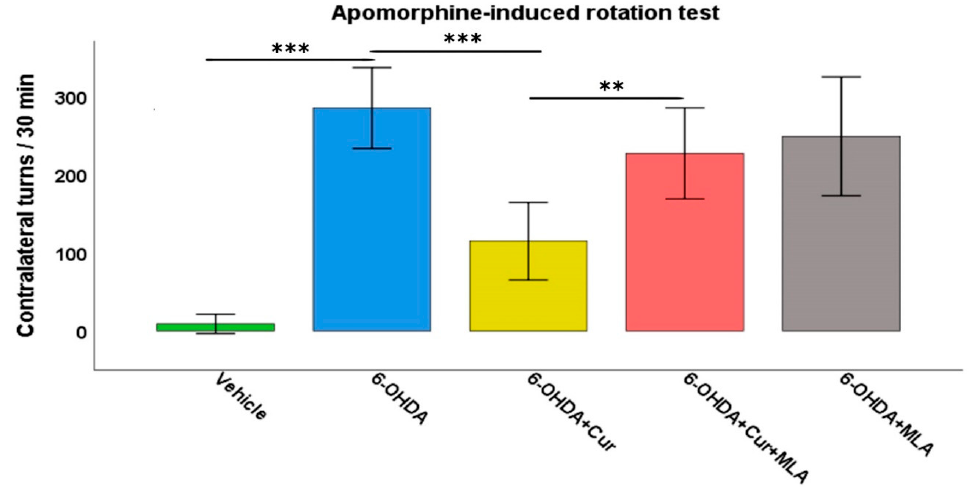
Figure 1. The motor performance of rats was assessed using an apomorphine-induced rotation test (0.25 mg / kg) expressed as full body turns over a period of 30 min. The vehicle group showed a